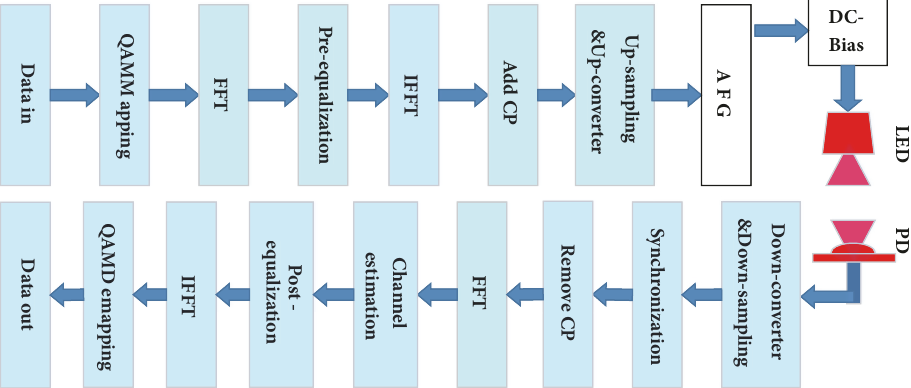
Figure 4: Block diagram of the SC-FDE based VLC system.